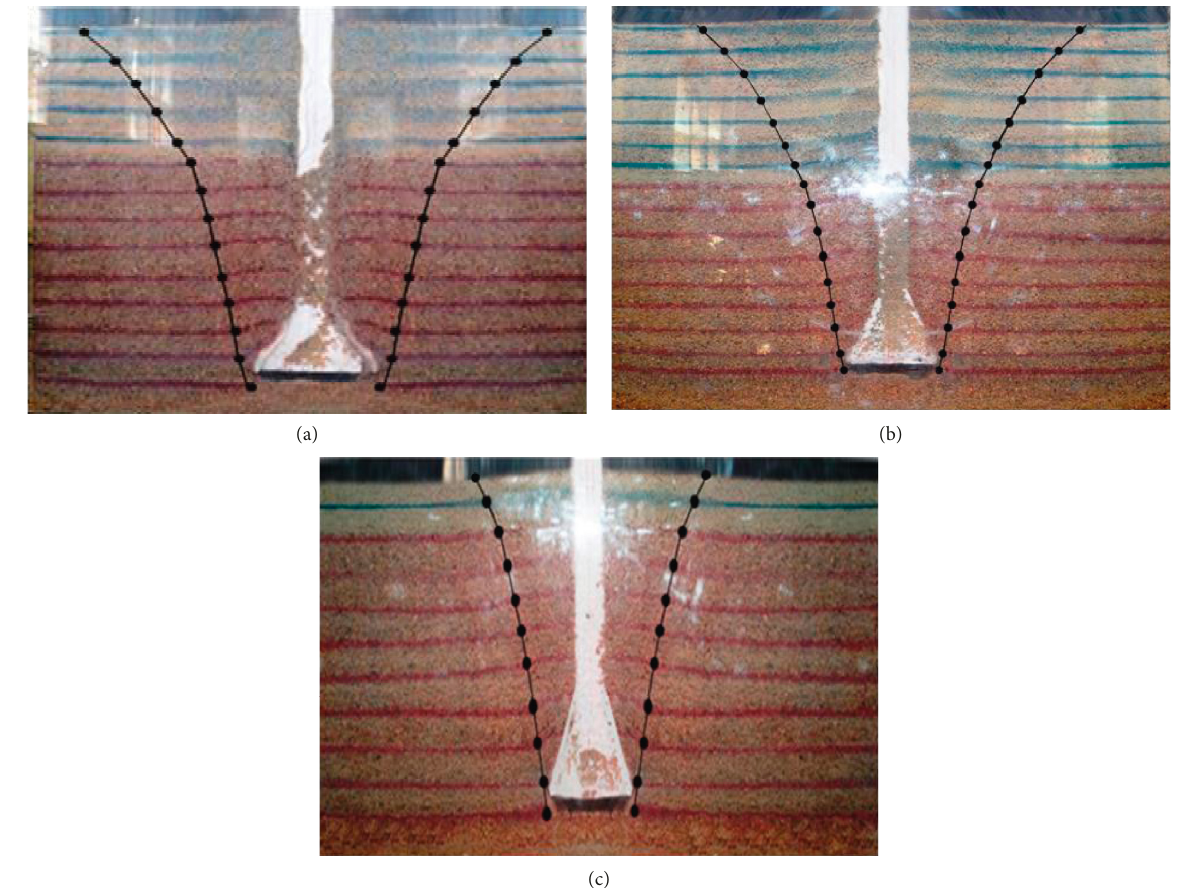
II /0.61 S I ), (b) panel 2D:63-0.33-4-